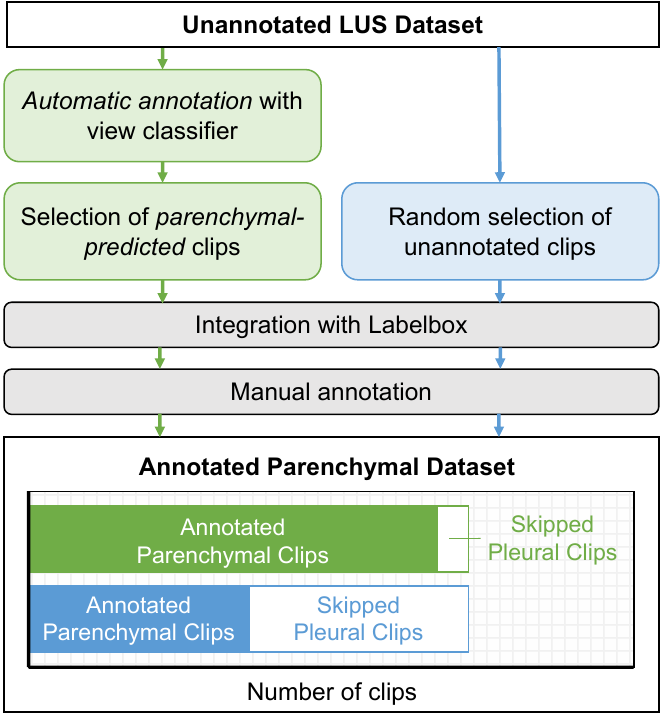
Figure 4. Annotation workflow with (green) and without (blue) automatic view annotation for a parenchymal-specific annotation task. Annotators need only be provided with parenchymal- predicted clips for a parenchymal-specific labelling task, resulting in more annoated parenchymal clips per labelling sprint and fewer skipped pleural clips, saving annotation